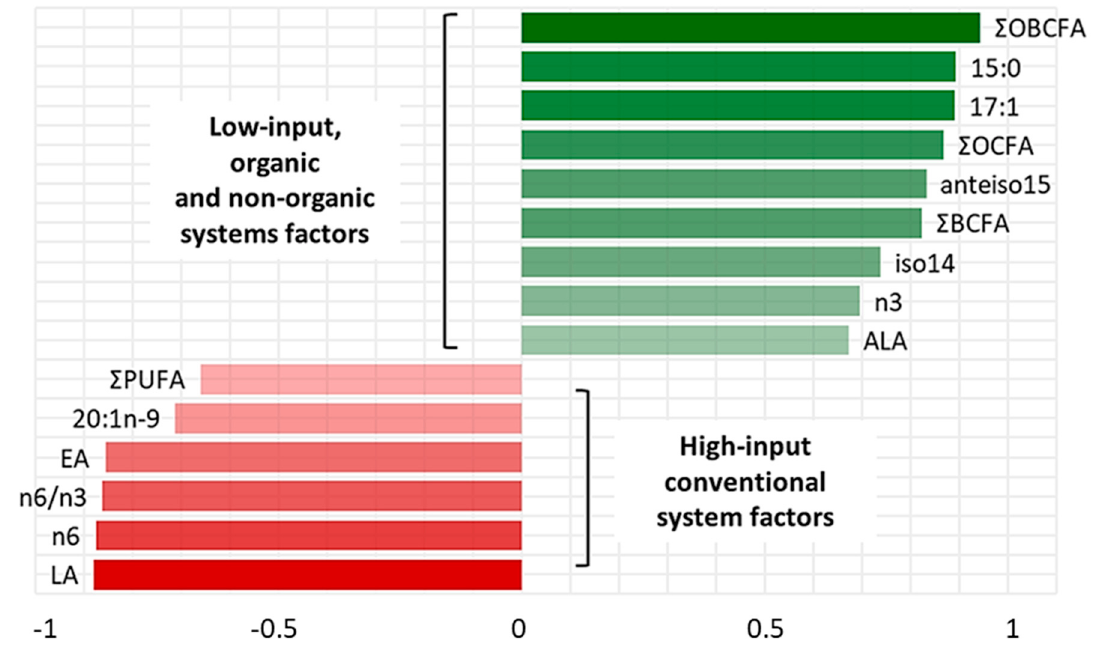
Figure 2. Principal Component-2 eigenvectors of factors considered as representative of the low-input and the high-input systems. Variables with absolute values of their eigenvectors equal or greater than 0.6 have been chosen. Factors with the higher absolute values of their eigenvectors are associated with a higher influence on data variability.